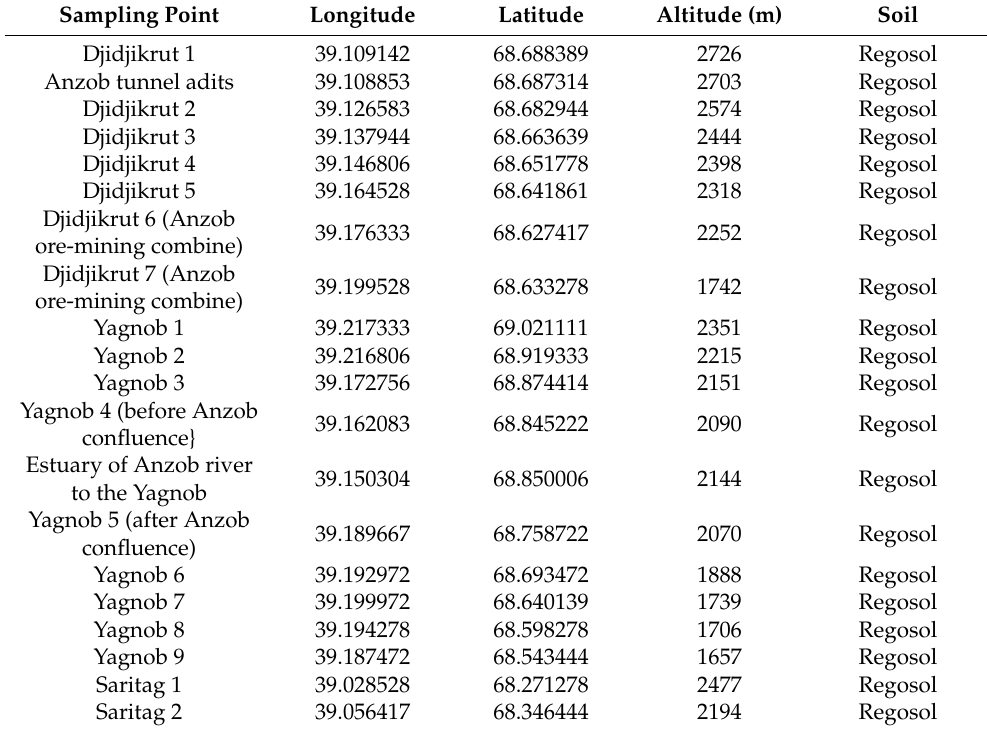
Figure A1. The map of Zarafshon catchment basin showing locations of the main sources of anthropogenic contamination [6]. Table A1. Sampling points coordinates, altitude as well as the local type of soil.